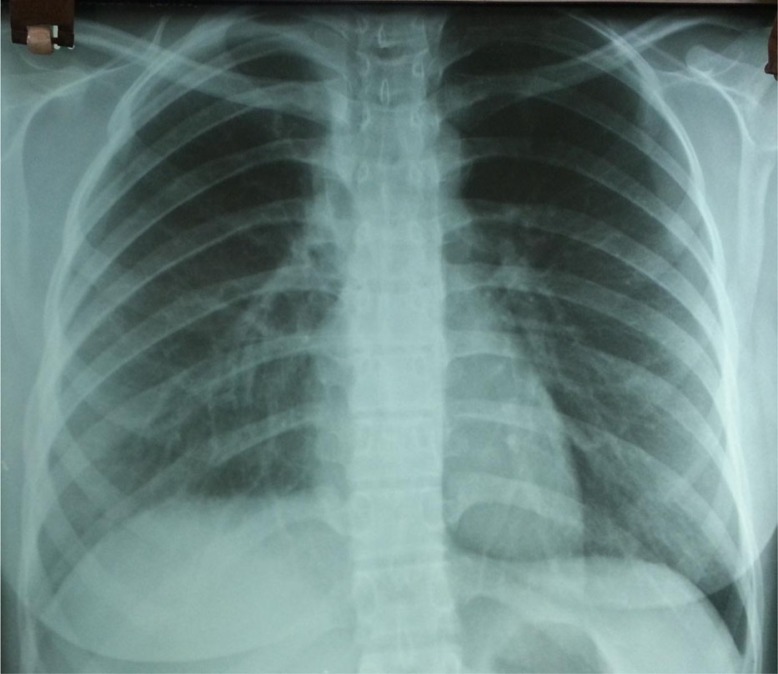
Postop radiograph.